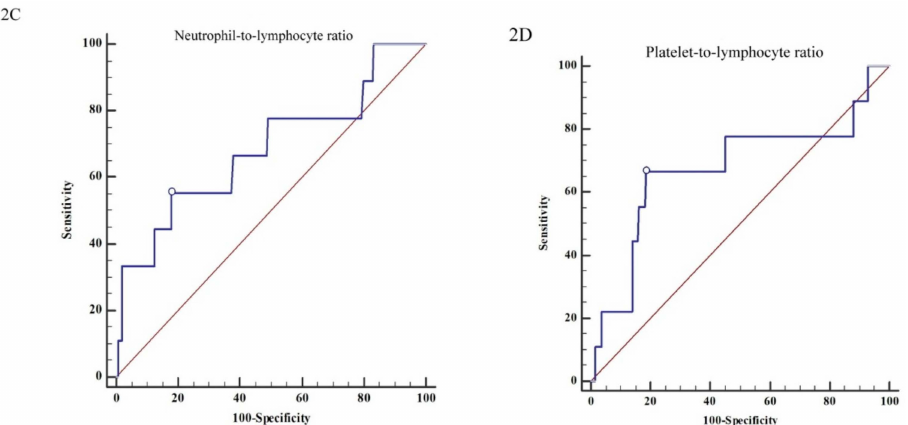
Figure 2. Predicting patients’ survival of IgA nephropathy with C3 level, IgG level, ratio of neutrophil / lymphocyte, and ratio of platelet / lymphocyte. ( 2A ) C3 predicted patients’ survival with poor power (AUC = 0.568, sensitivity = 33.33%, specificity = 99.02%). ( 2B ) IgG predicted patients’ survival with fair power (AUC = 0.648, sensitivity = 66.67%, specificity = 74.82%). ( 2C ) Neutrophil-to-lymphocyte ratio predicted patients’ survival with fair power (AUC = 0.684, sensitivity = 55.56%, specificity = 82.08%). ( 2D ) Platelet-to-lymphocyte ratio predicted patients’ survival with good power (AUC = 0.673, sensitivity = 66.67%, specificity =